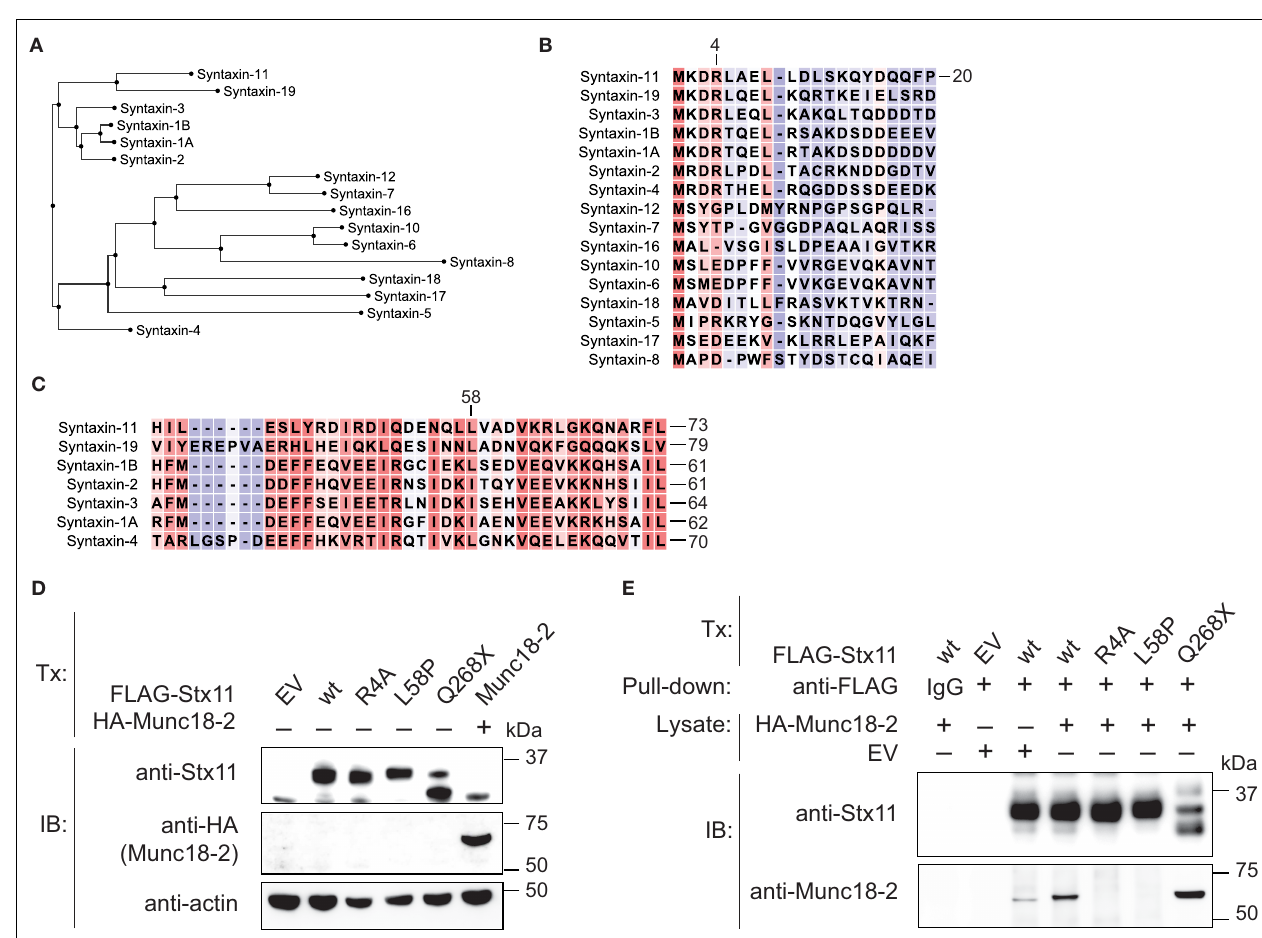
HA-Munc18-2 wild-type.Twenty-four hours after transfection,WCL were prepared and analyzed for expression of Stx11, Munc18-2, and actin. (E) HEK-293T cells constructs as indicated.Twenty-four hours after transfection,WCL were prepared from Stx11 transfectants and Stx11 was immunoprecipitated to beads.The beads were washed extensively and thereafter incubated withWCL from EV or HA-Munc18-2 wt transfected HEK-293T cells. Beads were washed, proteins eluted, and analyzed by Western blotting with antibodies as